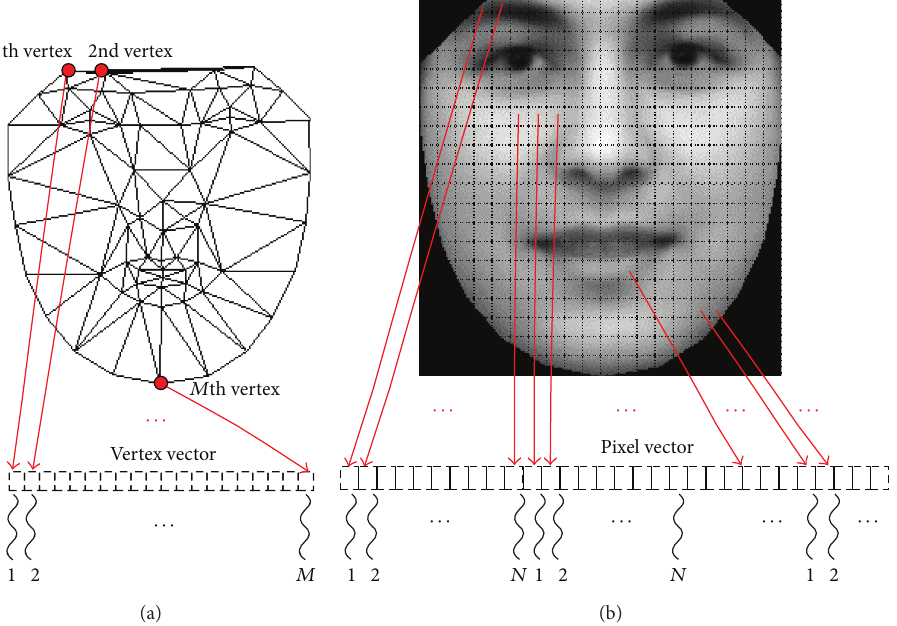
Figure 3: (a) The design idea of calculating the shape vector, 𝑆 . Here, 𝑀 is the number of vertices in 𝑆 , which equals the number of threads involved in the calculation. (b) The design idea of the remaining four subprocedures focuses on computing 𝑔 𝑠 and 𝑔 𝑚 .